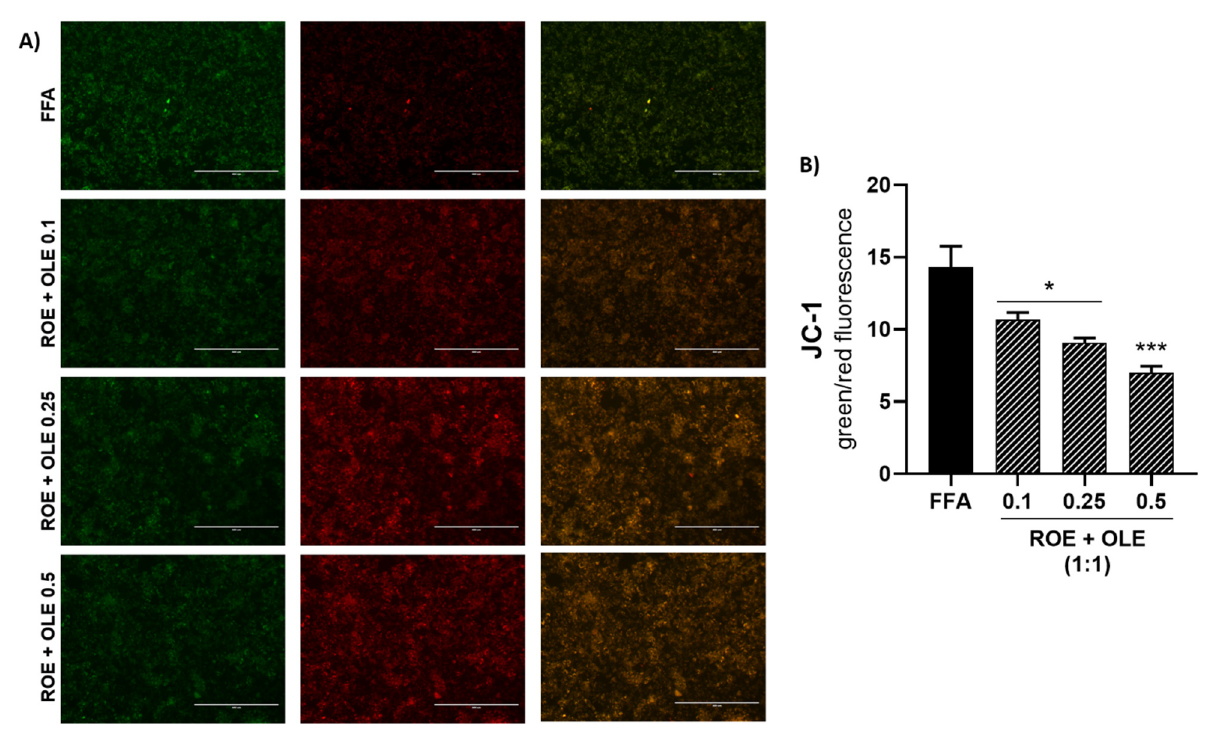
Figure 5. ( A ) Fluorescence images of JC-1 staining after 6 h of treatment. ( B ) Effect of ROE and OLE combinations on mitochondrial membrane potential. Significant vs FFA: * p < 0.05; *** p <